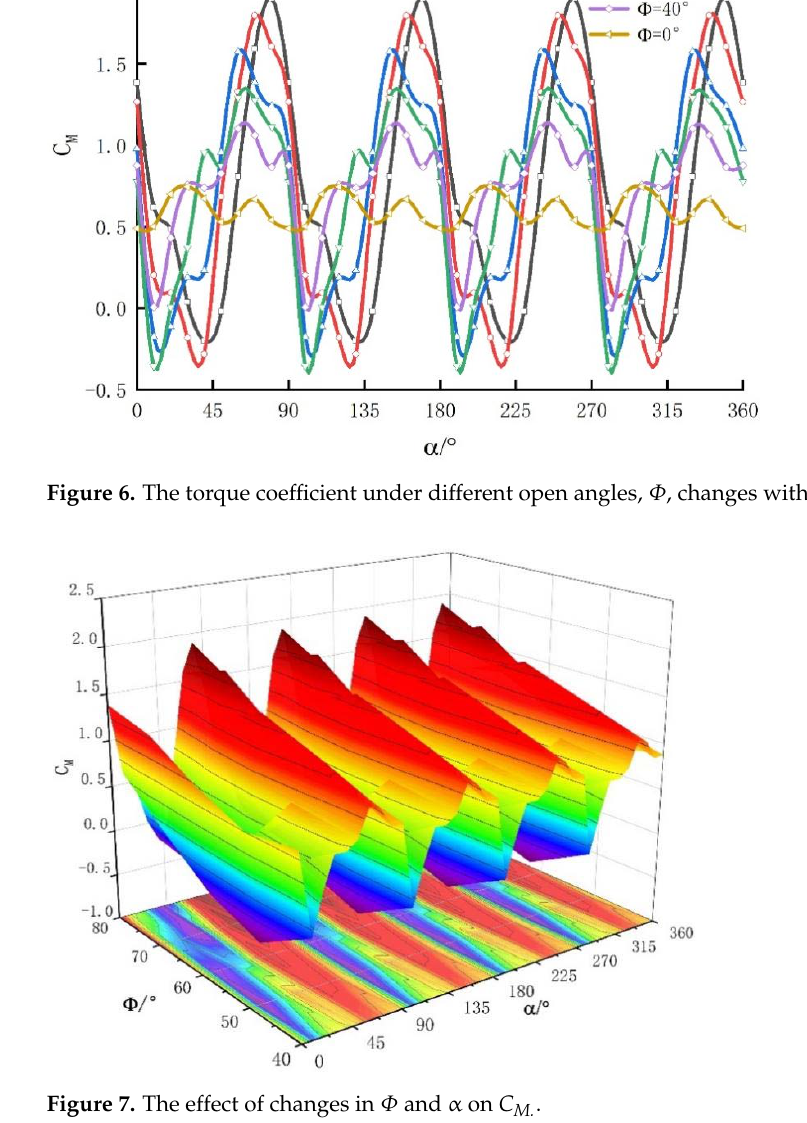
Table 3. Specific parameters of small generator.